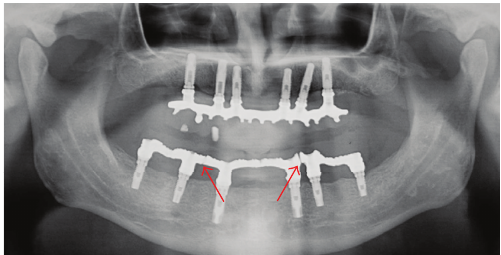
Figure 5: Panoramic radiograph after a year of installation of the mandibular fixed implant-supported prosthesis. Red arrows show the cuts in